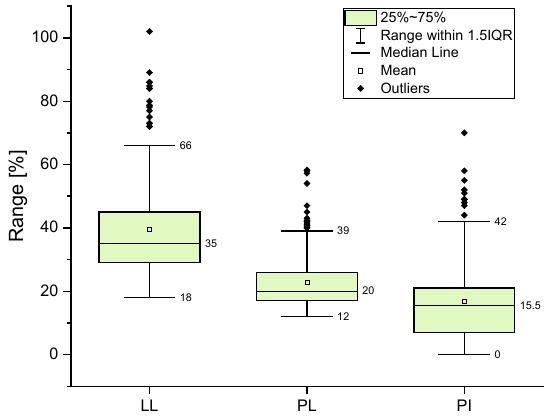
Figure 4. Box plot of LL, PL, and PI.